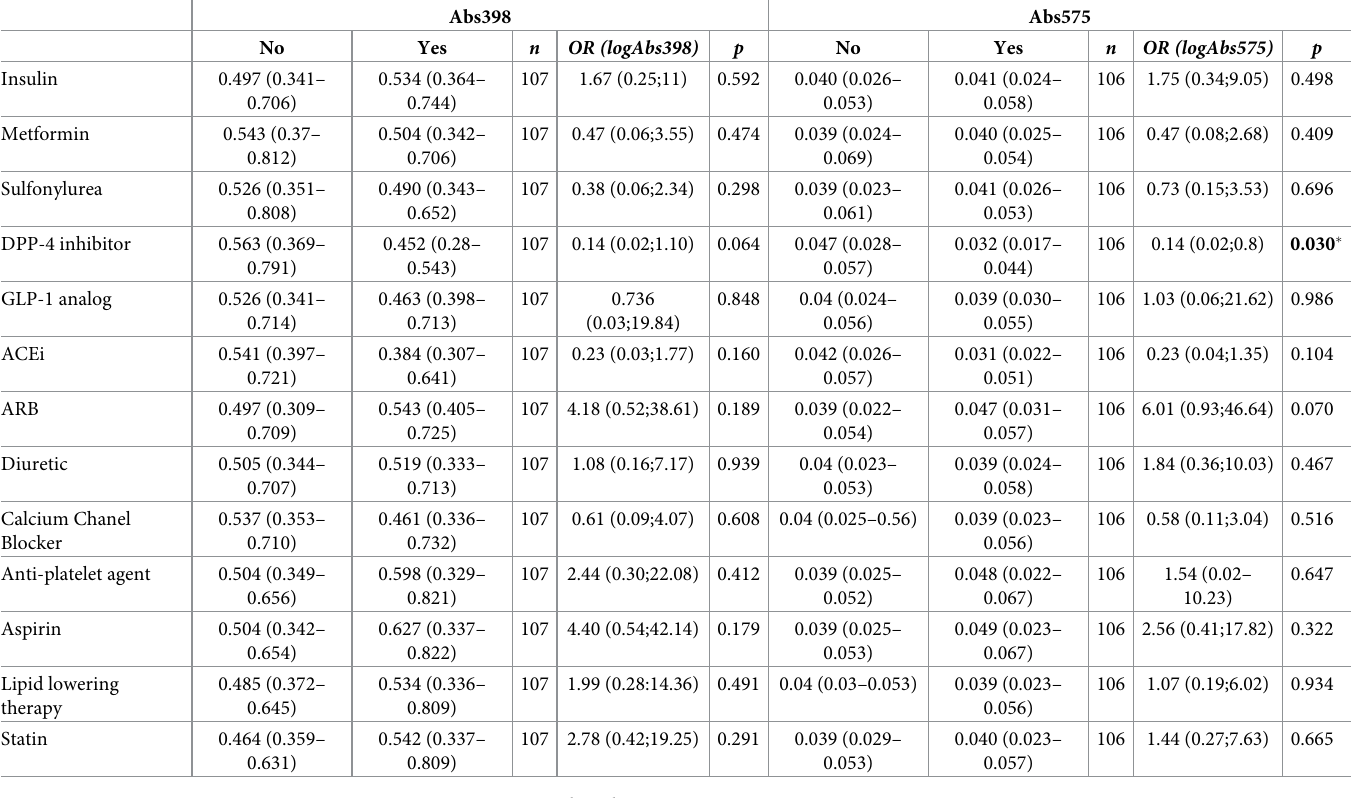
Table 3. Associations between IVH markers and treatments in T2D patients: Odds Ratios and their 95% confidence intervals after adjustment for age and